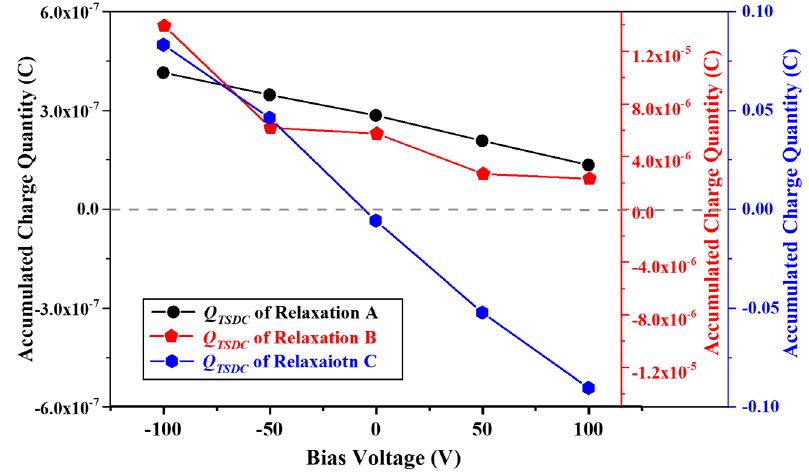
Figure 6. Relationship between accumulated charge quantity and bias voltage.